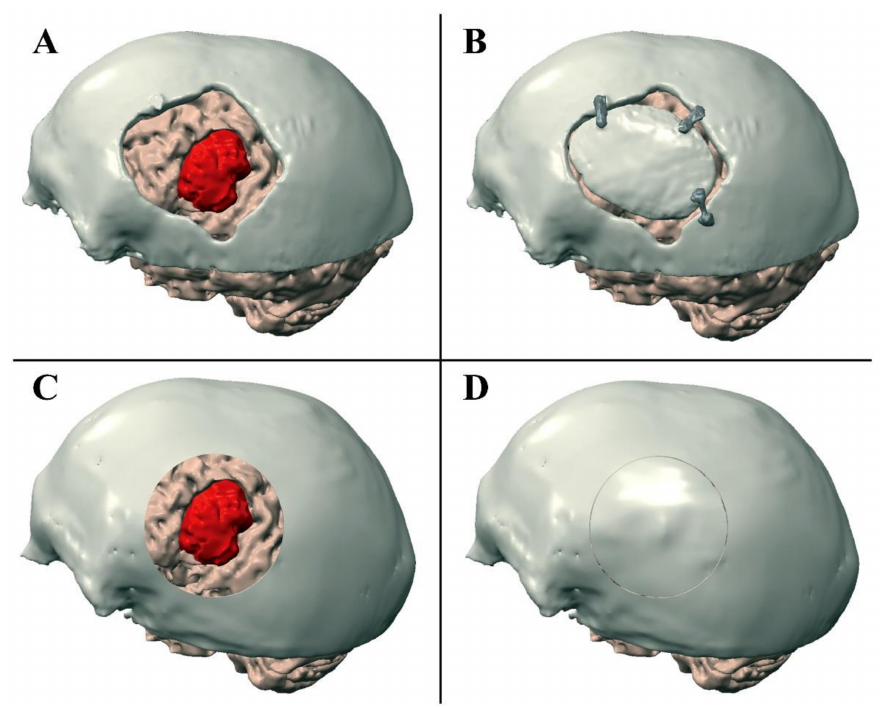
Figure 3. Performed craniotomy ( A , B ) and VOSTARS planning ( C , D ). ( A ) Shows the post-operative skull model was registered to the preoperative brain model. ( B ) Shows the position of the bone flap cranioplasty with polymethylmethacrylate. ( C ) Shows the craniotomy planned with VOSTARS. ( D ) Shows the result of the ideal post-operative bone flap cranioplasty on the manikin’s head.